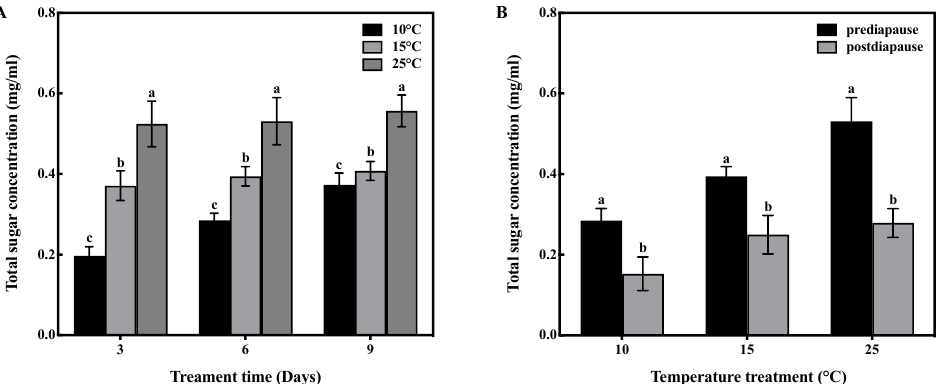
Figure 4. Effect of temperature acclimation on total sugar concentration in the fat bodies of queens. The values represent the concentrations (in mg/mL) of tissue samples of medium volume for each sample. ( A ) Effect of temperature acclimation on total sugar concentration in the fat bodies of queens during prediapause. Different letters represent statistical significance between the different temperatures ( p < 0.05). ( B ) Effect of temperature acclimation for 6 days during prediapause on total sugar consumption of queens during diapause. Different letters represent statistical significance between the different periods of diapause ( p <